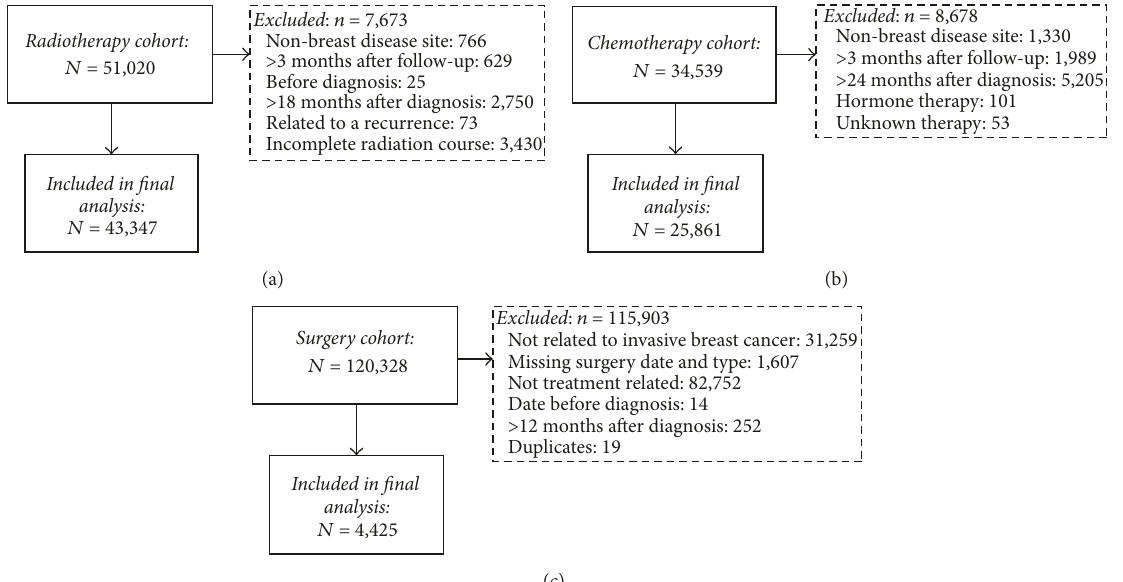
Figure 2: Selection of (a) radiotherapy records and (b) chemotherapy records within the Activity Level Reporting database and (c) surgery records within the Canadian Institute for Health Information